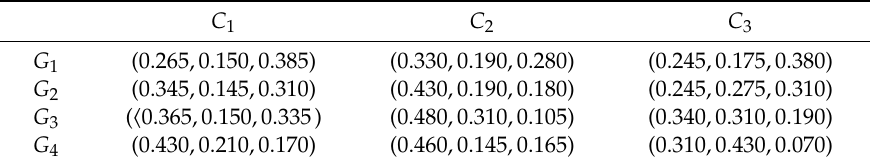
Table 8. Air quality data from station O 1 .